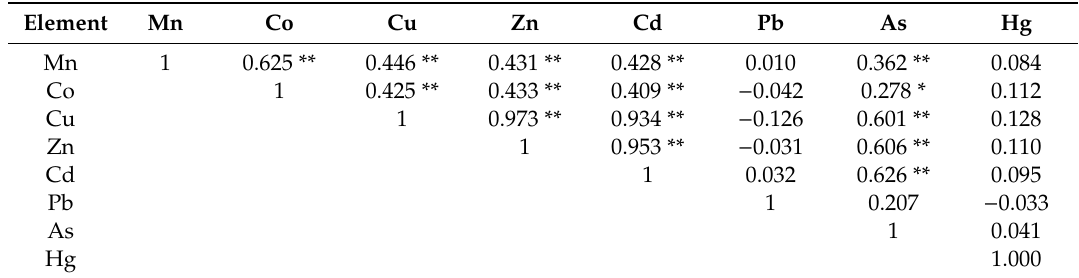
Table 5. Correlation coe ffi cients between PTEs in soils.